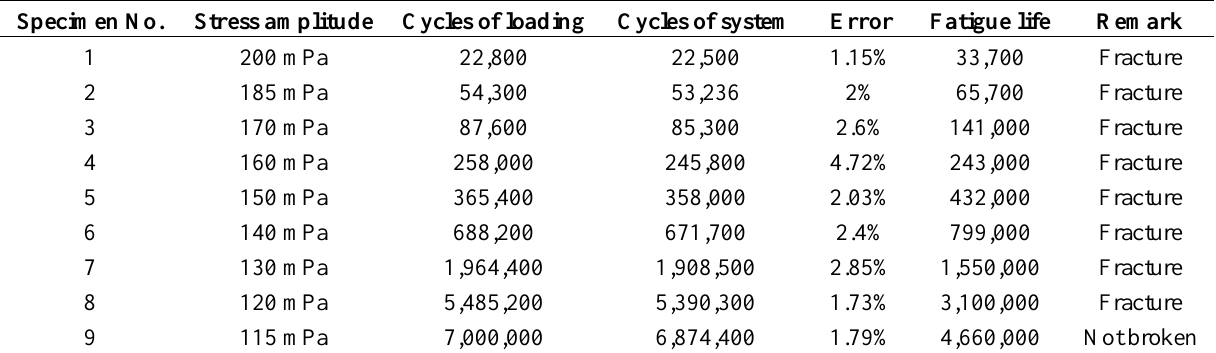
Table 8. Fatigue test results based on the PVDF.